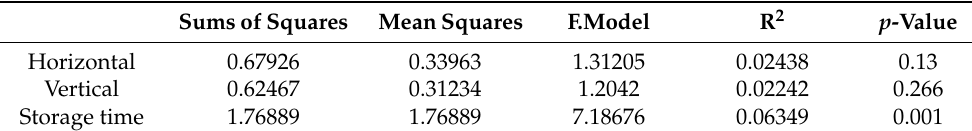
Table 3. Multivariate analysis of variance of the orientation, vertical position and storage time effect on fungi.